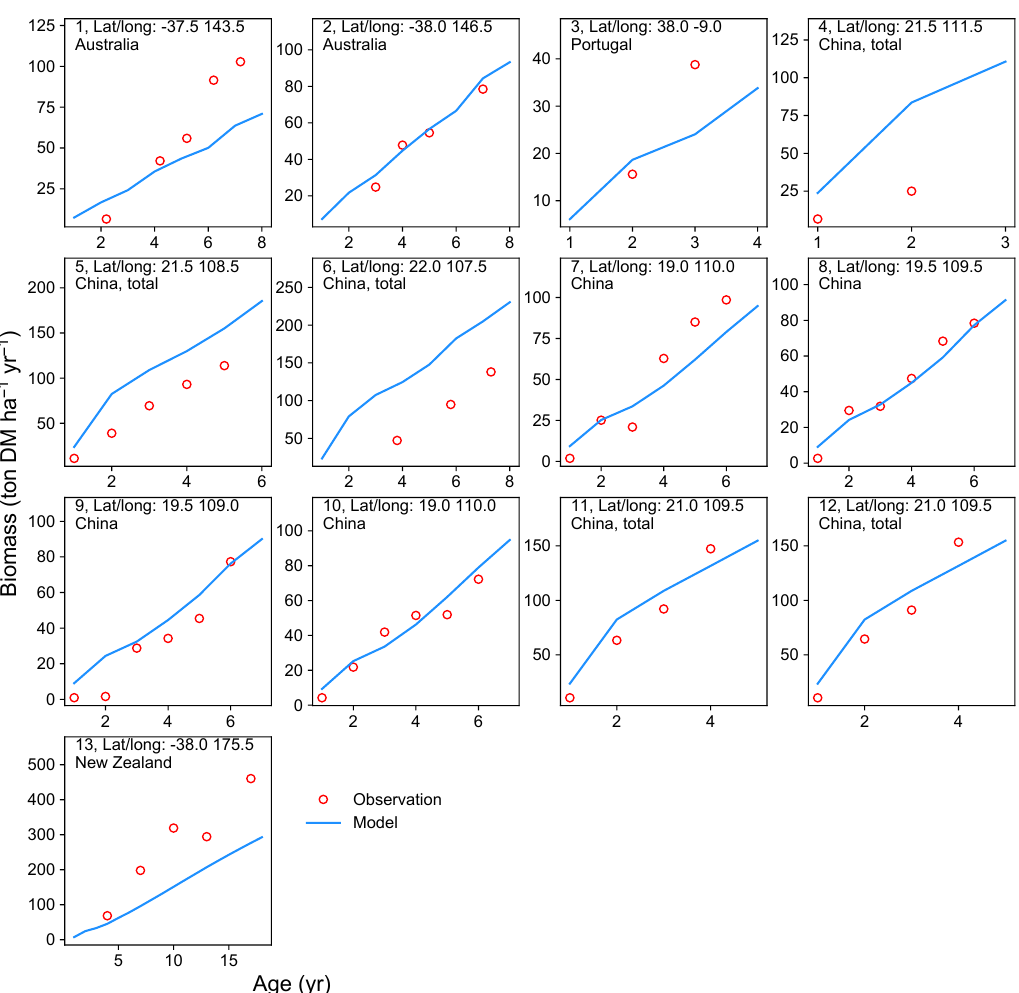
Figure 4. Biomass–age curves at different sites for PFT14 (tropical bioenergy tree, eucalypt). The site number, coordinates, and country for each site are also shown. Biomass at most sites refers to aboveground biomass, except Site nos. 5, 11, and 12 (labeled “total”, i.e., the sum of aboveground and belowground biomass; the same total biomass from the model is used for these sites). The detailed site information is shown in Table